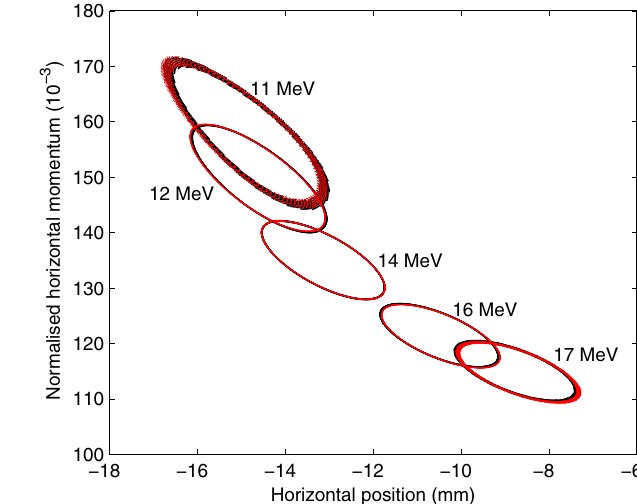
FIG. 13. Horizontal (blue) and vertical (red) tune per cell at various energies, found from a directly computed map, and from an interpolated MVGF map. The reference energy is 14 MeV. There is some small discrepancy in the results from different maps, but it is below the measurement precision of 0.01.